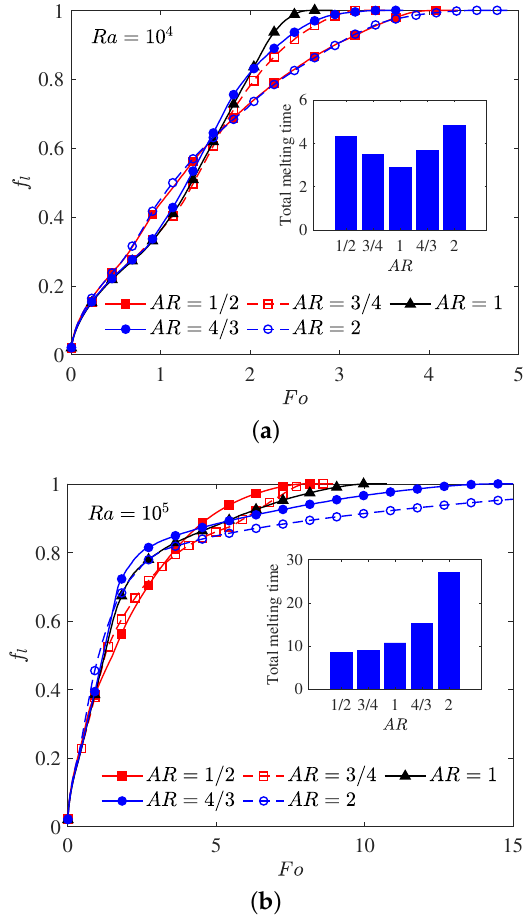
Figure 9. Time evolution of the total liquid fraction f l for different aspect ratios AR in which T = 500: ( a ) Ra = 10 4 ; ( b ) Ra = 10 5